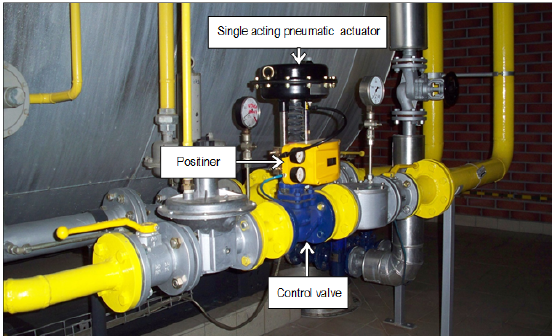
Figure 1. A snapshot of the exemplary application of an electro-pneumatic final control element in the liquid flow rate control loop in a